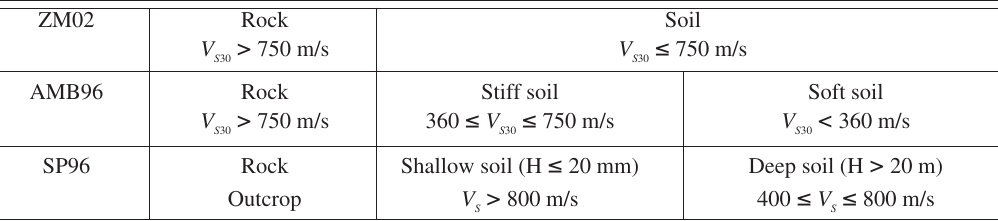
Table II. Correlation between different soil classifications used for attenuation relationships.